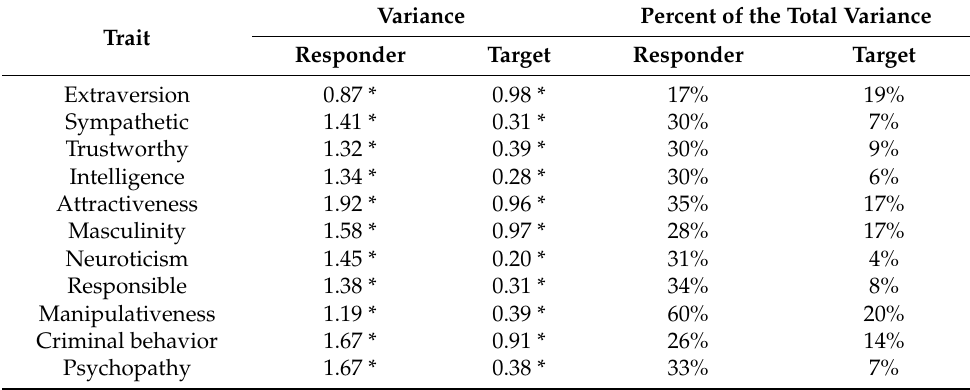
Table 3. Study 2: Social Relations Analysis of trait ratings.